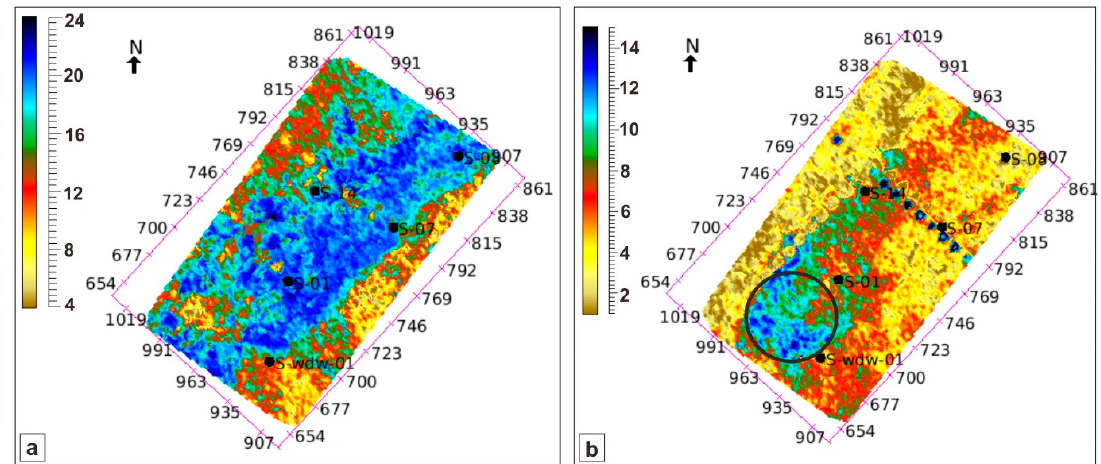
Figure 13. Porosity distribution maps of ( a ) C-sand interval and ( b ) B-sand interval. The black circle shows the high porosity region with no drilled well and can be exploited for future drillings.